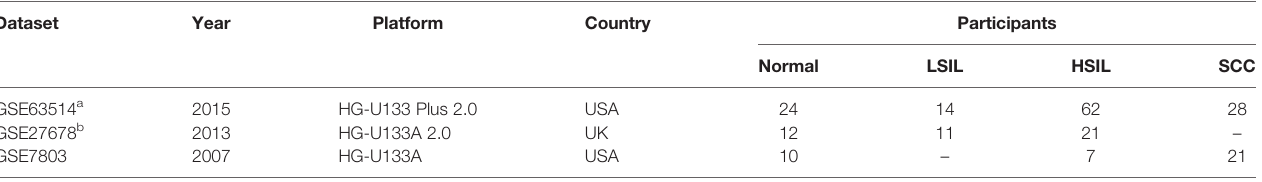
TABLE 1 | Microarray datasets included in this